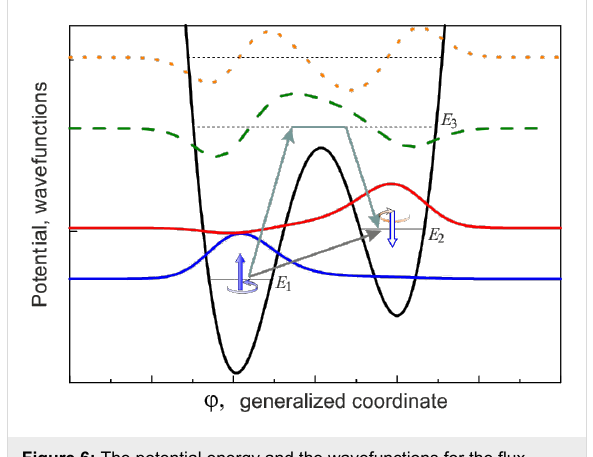
Figure 6: The potential energy and the wavefunctions for the flux- driven, three-junction qubit (described in [2]), where the Josephson energies of the elements are E J , E J and 0.9 E J ; the Josephson energy scale, E J , is 80 times larger than the characteristic Coulomb energy of the elements. The theoretical possibility of such selective magnetization reversal of a superconducting flux qubit using an SFQ pulse is confirmed by the results of the numerical simulation of the three-level system dynamics (see Figure 7).